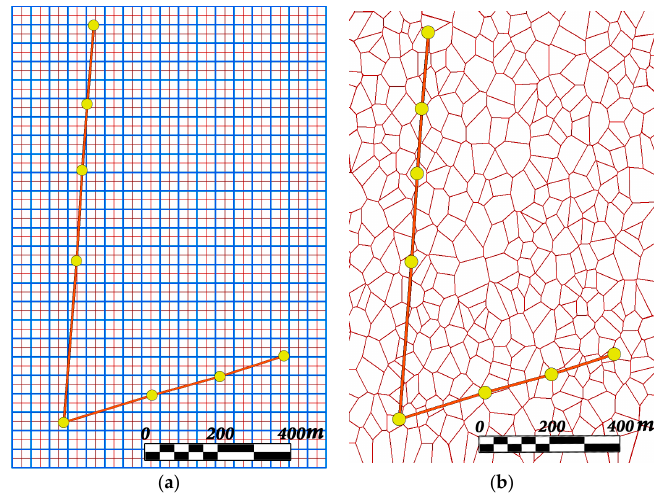
Figure 7. ( a ) Indicates a 25-m and a 50-m grid; ( b ) indicates a Voronoi diagram that divides the links into 30- to 100-m segments.